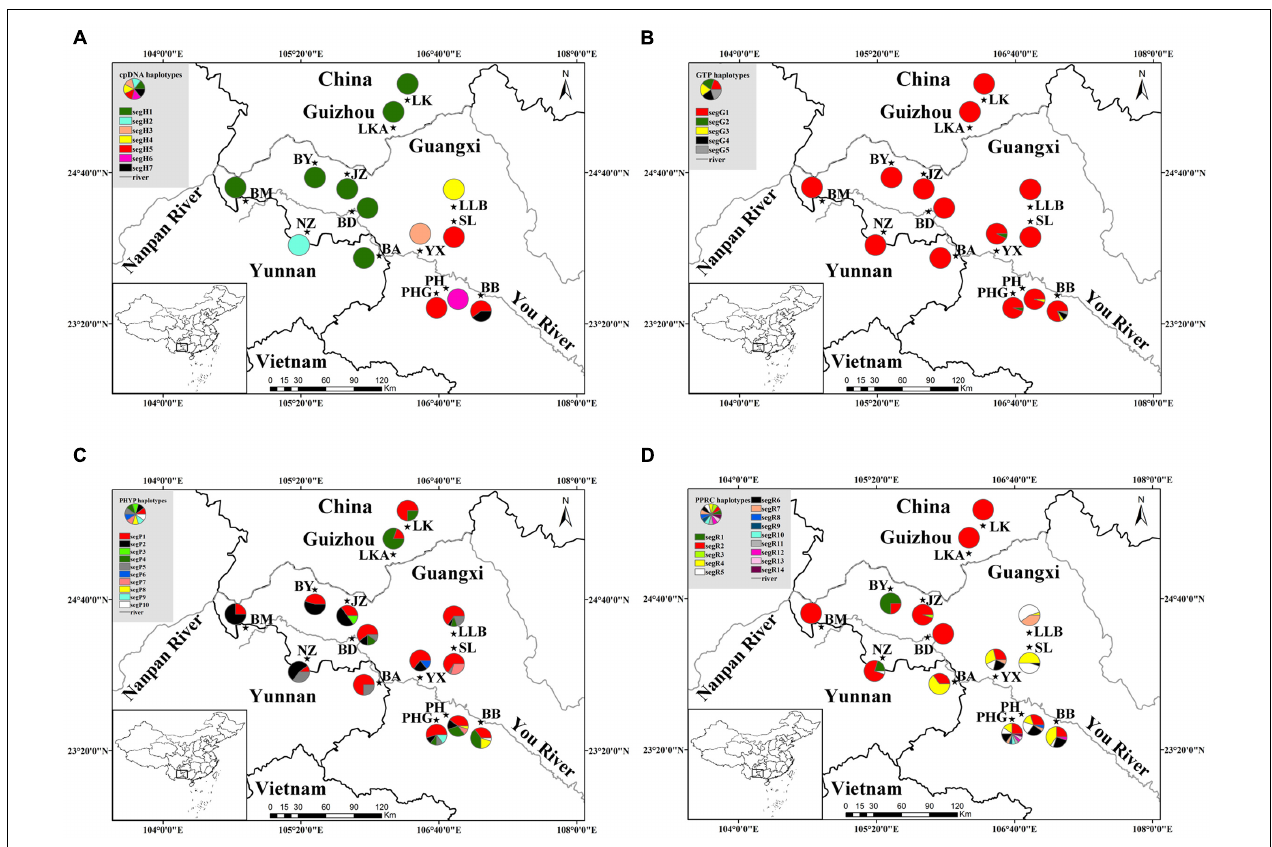
FIGURE 1 | Geographical distribution of 14 populations of C. segmentifida and distribution of its haplotypes detected from cpDNA (A) , GTP (B) , PHYP (C) , and PPRC (D) . Population codes refer to Supplementary Table S1.